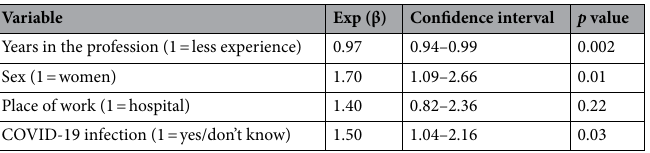
Table 6. Multivariable logistic regression model for acute stress and COVID-19 infection.